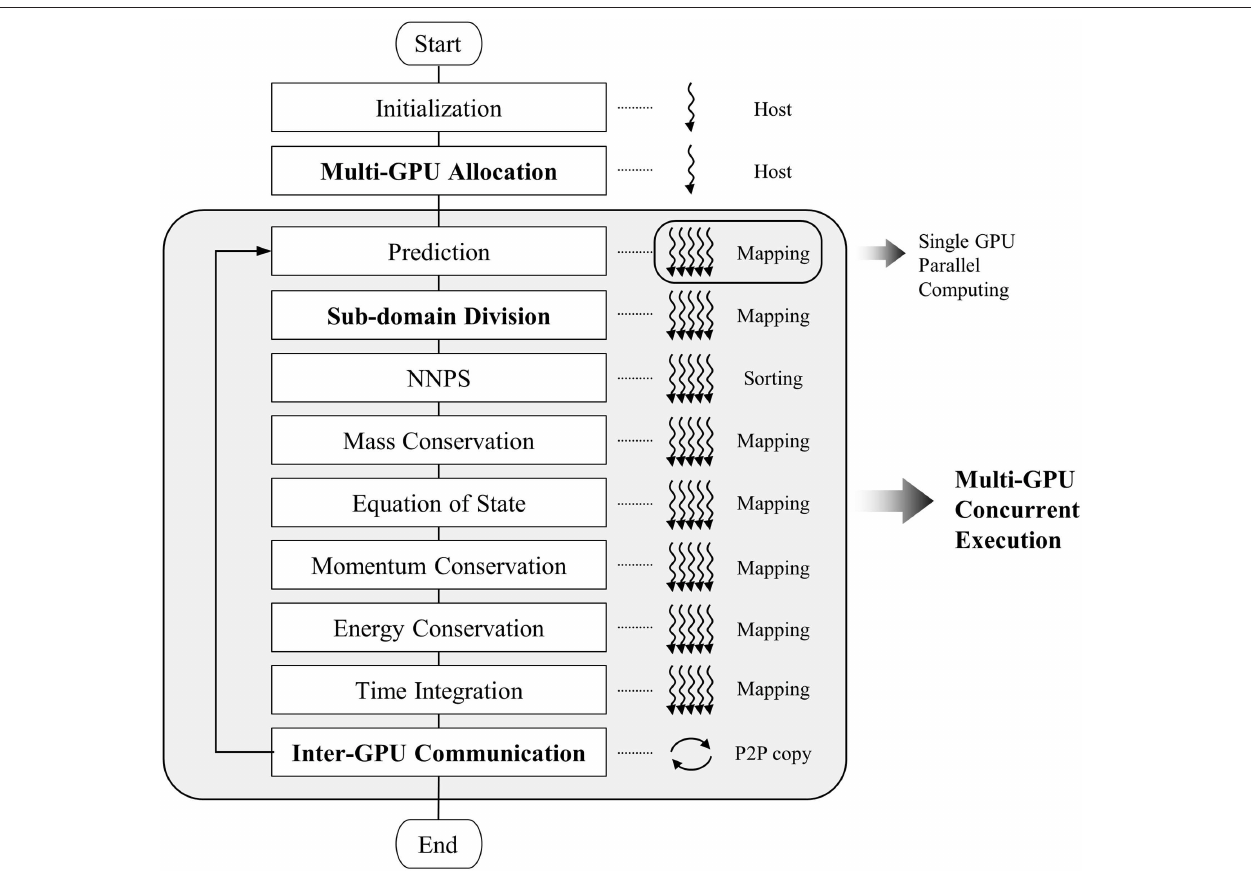
FIGURE 2 | Algorithm of the SOPHIA